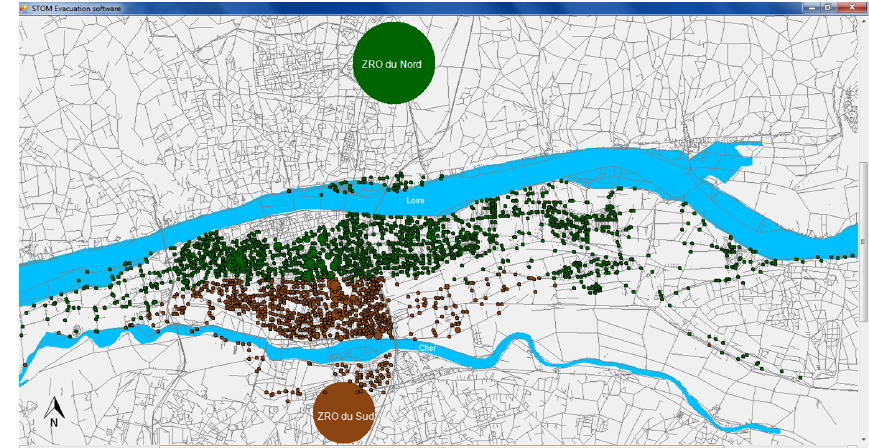
Figure 5. Assignment of buildings to safety points. Buildings in green are assigned to the northern shelter ( ZRO du Nord ) and the remaining buildings (in brown) are assigned to the southern shelter ( ZRO du Sud ).